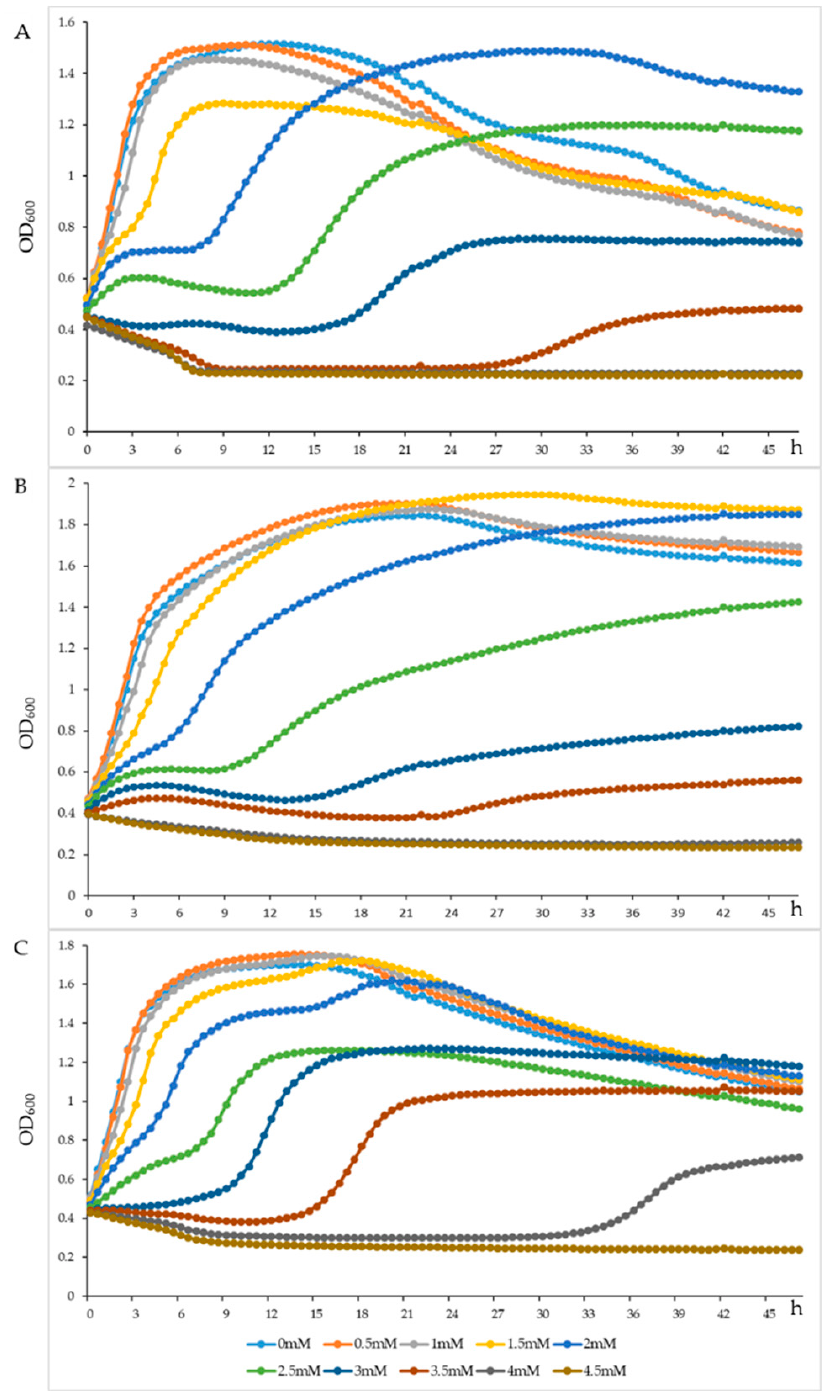
Figure 4. Growth density of the Lactiplantibacillus plantarum A1 ( A ), Lactiplantibacillus plantarum C1 ( B ) and Lactiplantibacillus plantarum C10 ( C ) strains under different concentration of H 2 O 2 . OD 600 = the absorbance at 600 nm of the Lactiplantibacillus plantarum A1, C1 and C10. 3.10. Improving the Antioxidant Activity of BJECs Compared to the control treatment, the coincubation of BJECs with L. plantarum A1, C1 or C10 significantly ( p < 0.05) reduced ROS levels in BJECs with (Figure 5A) or without (Figure 5B) exposure to H 2 O 2 . However, the T-AOC activity was only increased in BJECs after exposure to H 2 O 2 (Figure